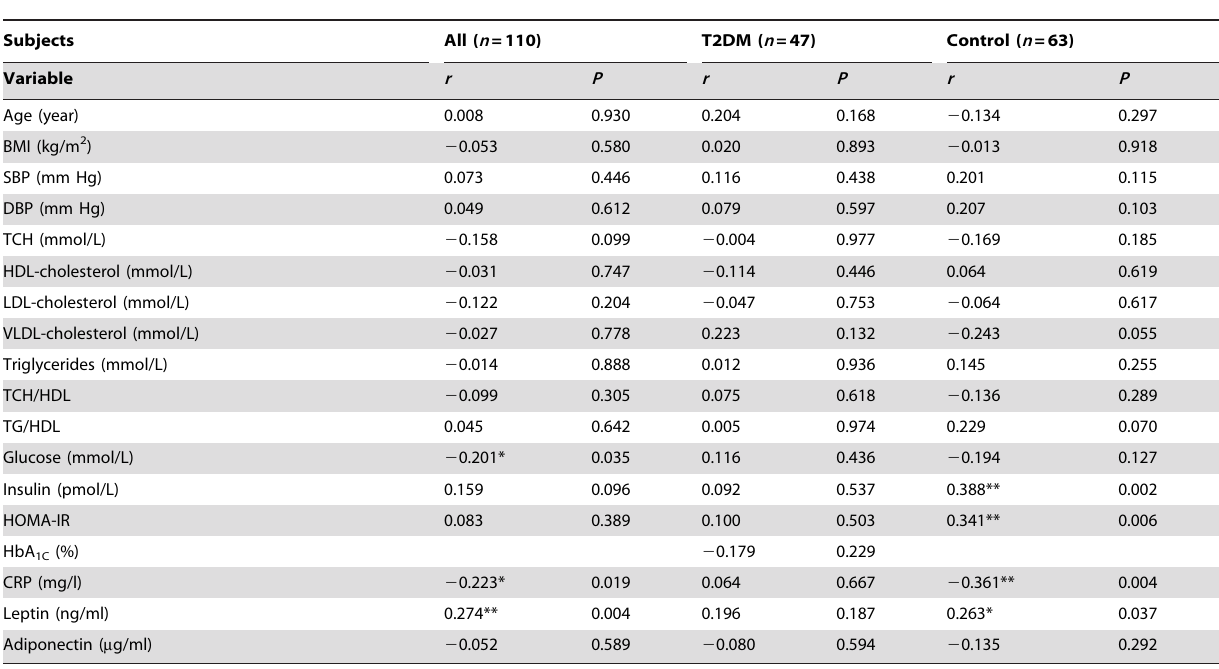
Figure 1. Effects of a 2 hour 75 g OGTT on serum glucose (A), insulin (B) and cartonectin (C) concentrations in T2DM subjects ( n =47). Group comparison by Wilcoxon matched pairs test. ** P , 0 ? 01. doi:10.1371/journal.pone.0112931.g001 Table 2. Linear regression analysis of variables associated with